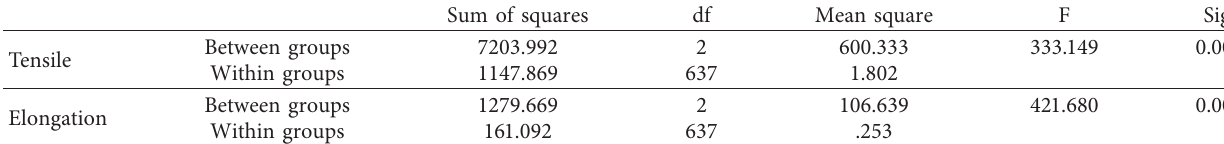
Yarn count Figure 6: Yarn elongation. Table 7: ANOVA results of yarn tensile and elongation for 20 Ne yarns. Sum of squares df Mean square F